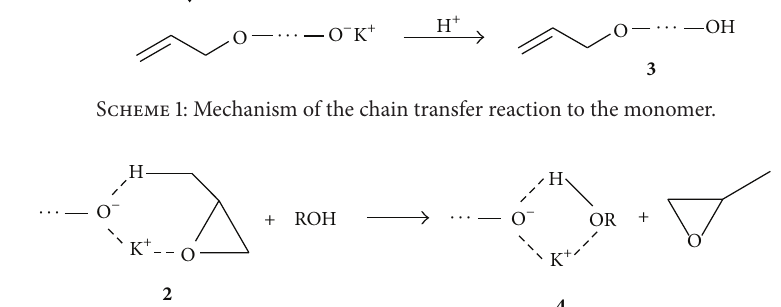
Scheme 2: Decomposition of the alkoxide active centre/PO complex 2 under influence of